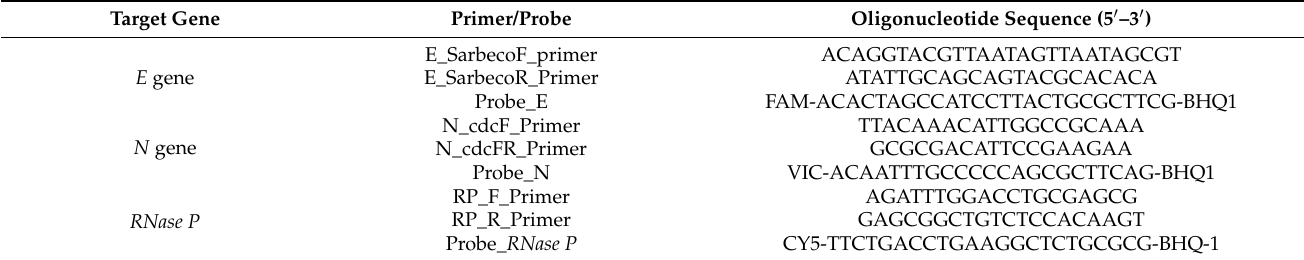
Table 1. Primers and probes used for in-house assay of SARS-CoV-2.